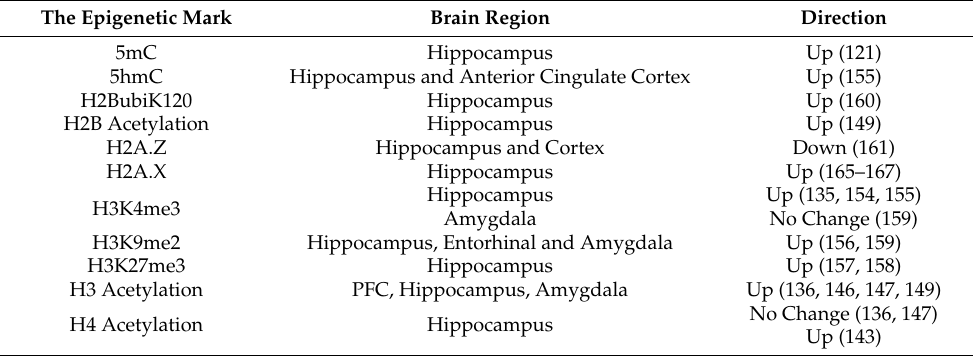
Table 1. List of known epigenetic marks altered during memory formation in a healthy